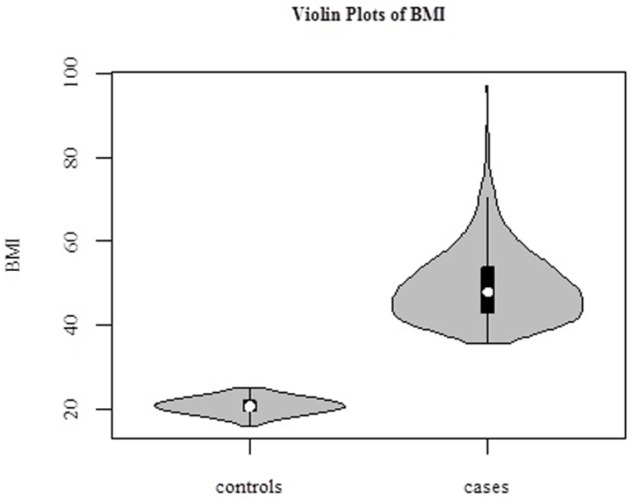
Violin plots of BMI in 1030 samples. Cases (BMI > 35 kg/m2, N = 493), and controls (BMI < 25 kg/m2, N = 537).